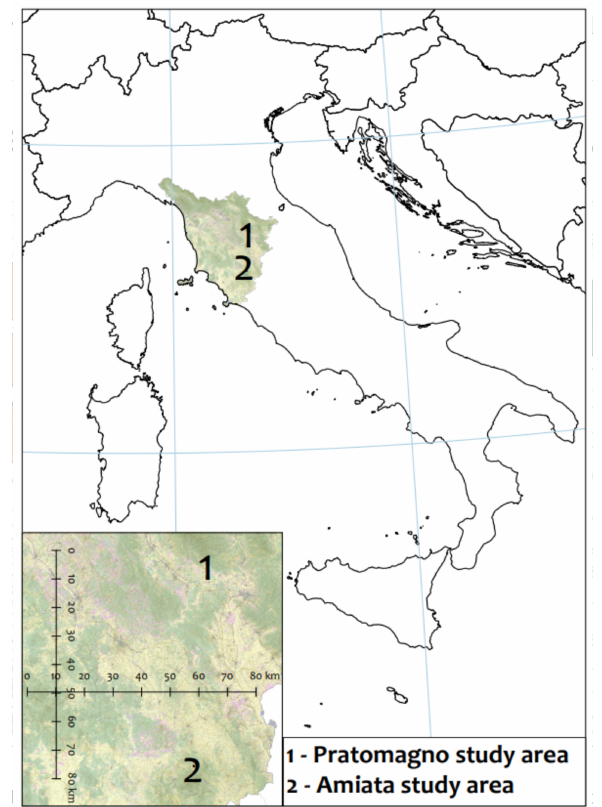
Figure 1. Geographic position of the two study